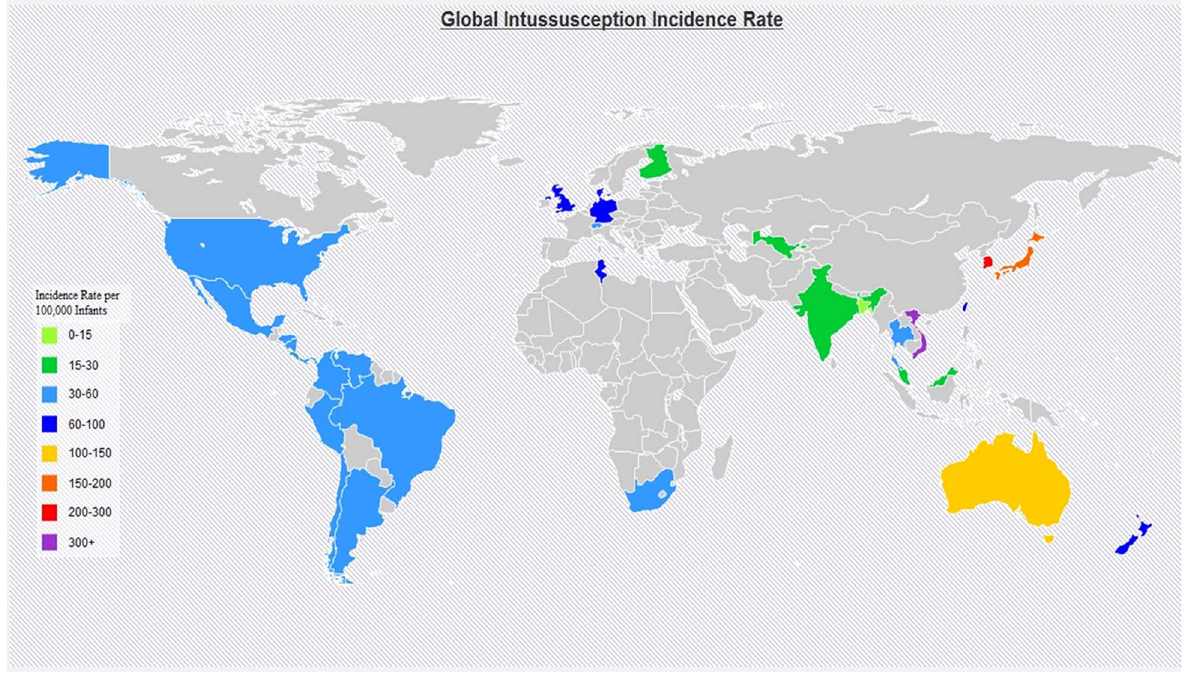
Figure 2. Global map of intussusception incidence. In countries where local, regional, and national studies were conducted, we preferentially mapped the national rates. For countries with more than one national study, average rates of the studies were used for the map. If no national rates were available, regional and/or local rates were used for the map.